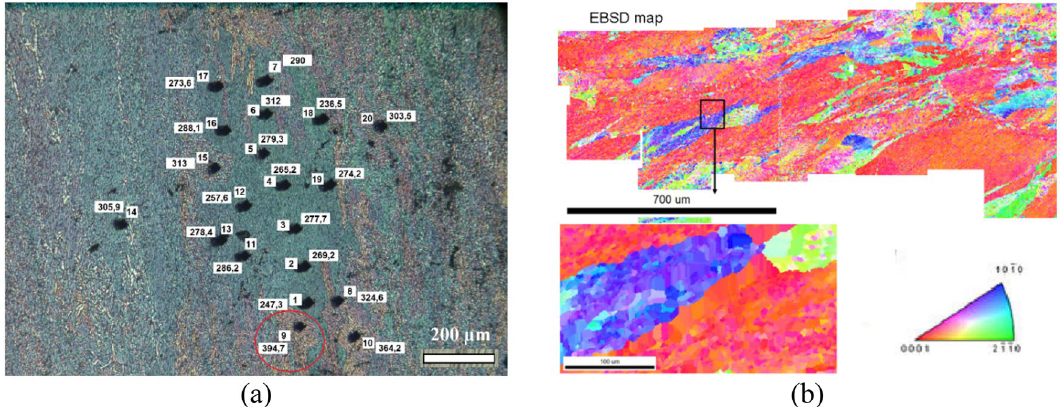
Fig. 9 Examples of microhardness measurements of VT3-1 titanium alloy in the macrozone ( a ) and example of electron backscatter diffrac- tion (EBSD) analysis of a significant surface of a thin section ( b )